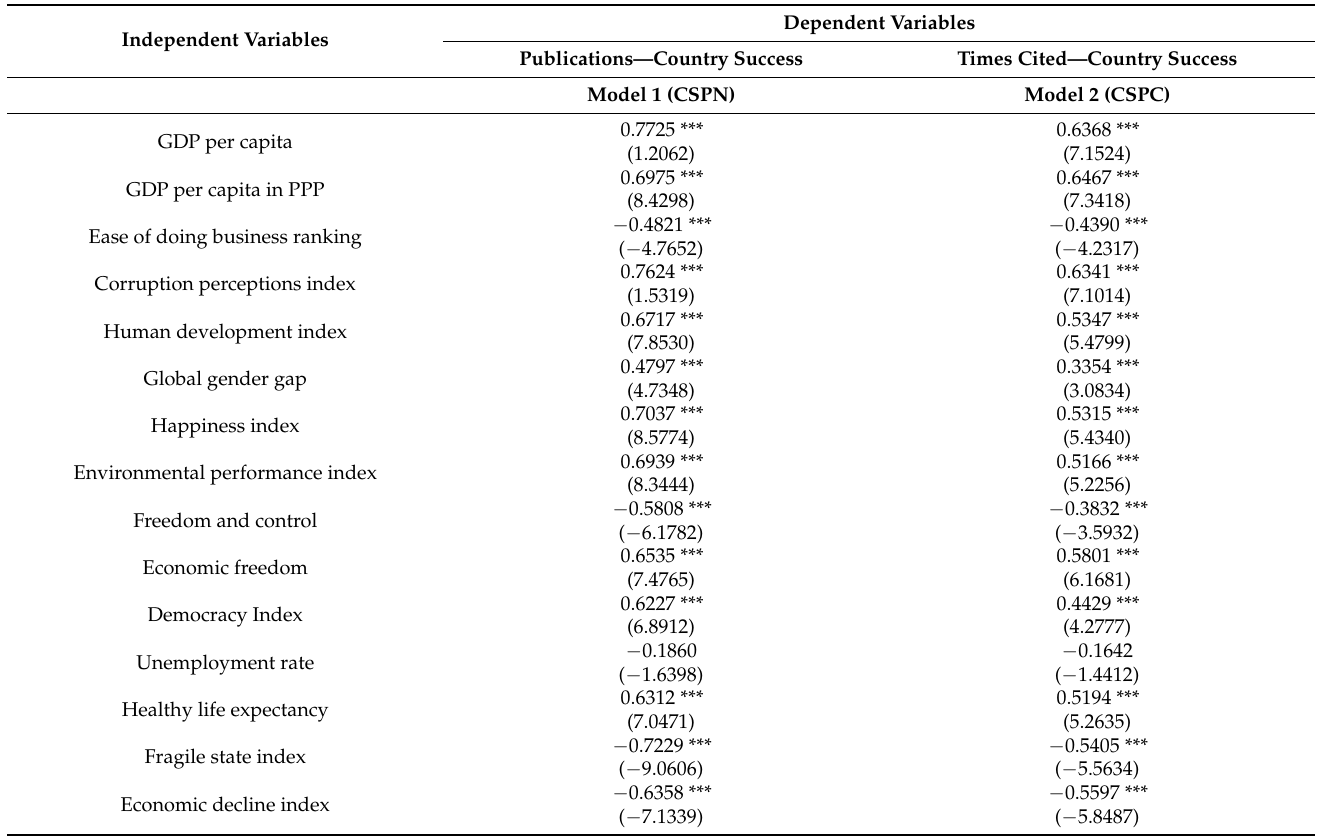
Table 5. Goodness-of-fit testing for two